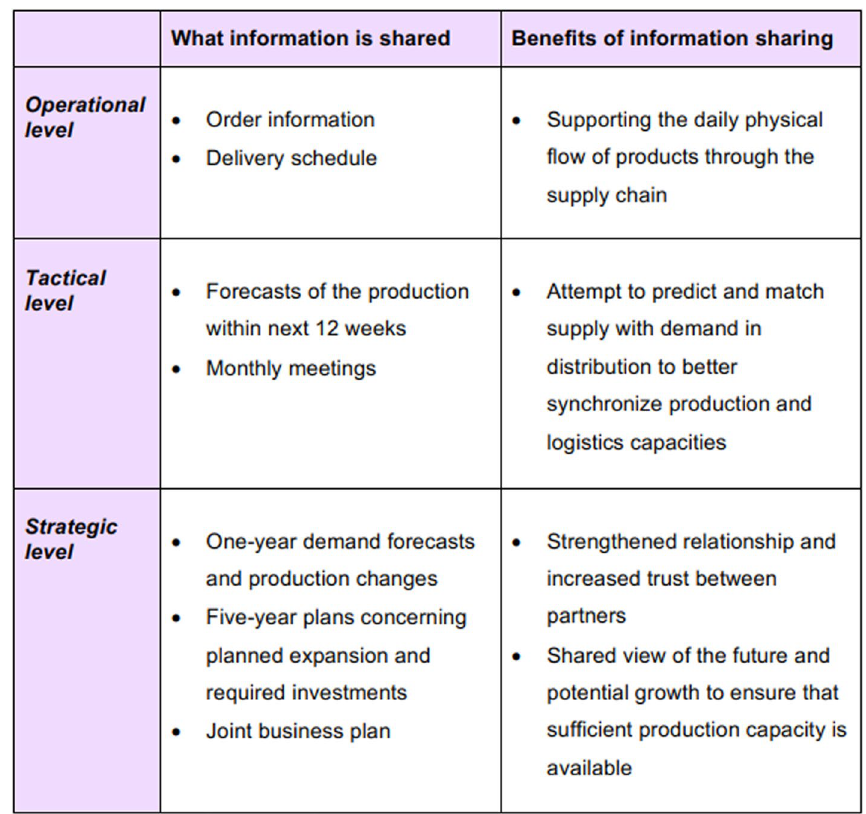
Fig. 2 Supply chain planning using